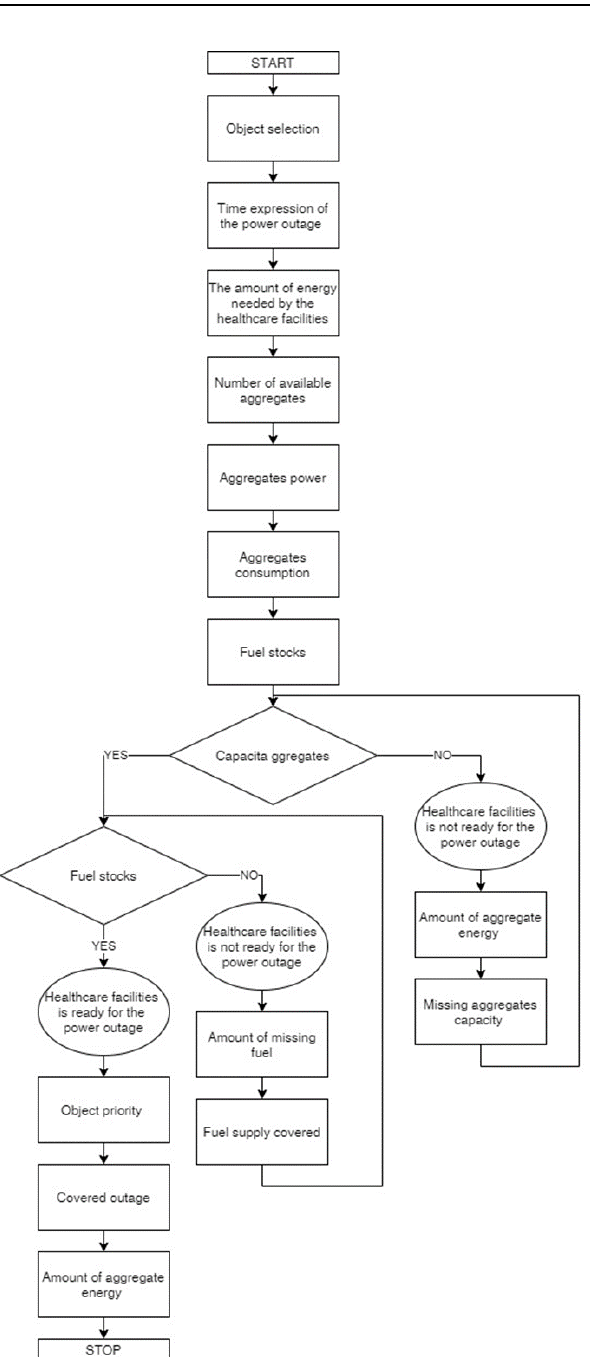
Figure 1. Design of the algorithm for assessing the healthcare facilities to solve power outages.